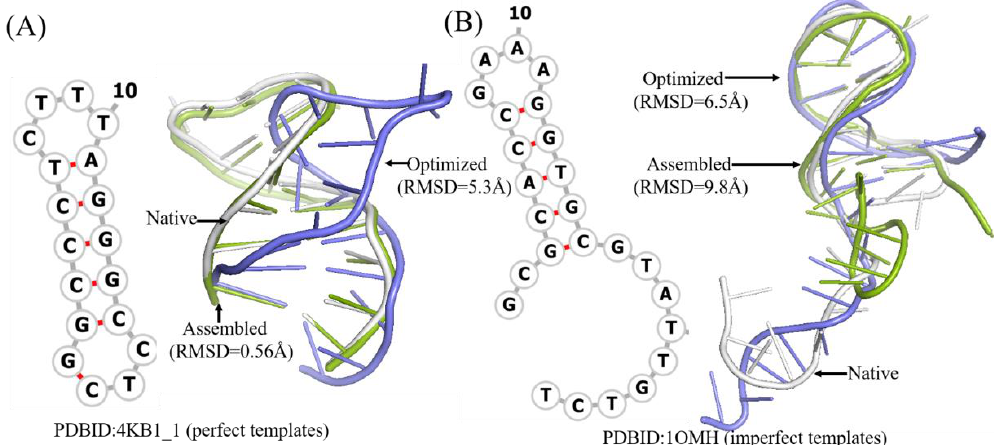
Figure 3. Two example of predicted 3D structures by 3dDNA. ( A ) The 2D and 3D structures of DNA 4KB1_1 with perfect template; the RMSD of assembled (green) and optimized (blue) structures with a native one (grey) are 0.56 Å and 5.3 Å, respectively. ( B ) The 2D and predicted 3D structures of DNA 1OMH with imperfect template, the RMSD of assembled (green) and optimized (blue) structures with a native one (white) are 9.8 Å and 6.5 Å, respectively.